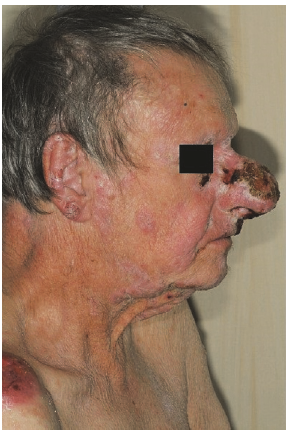
Figure 4: Aspect after radiotherapy (side